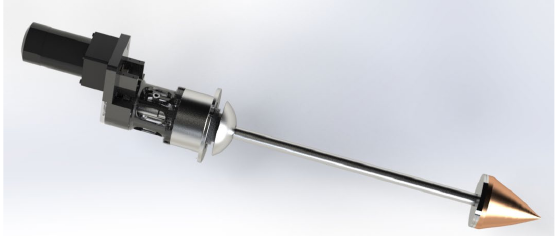
Fig. 9. Solid model of the reflector